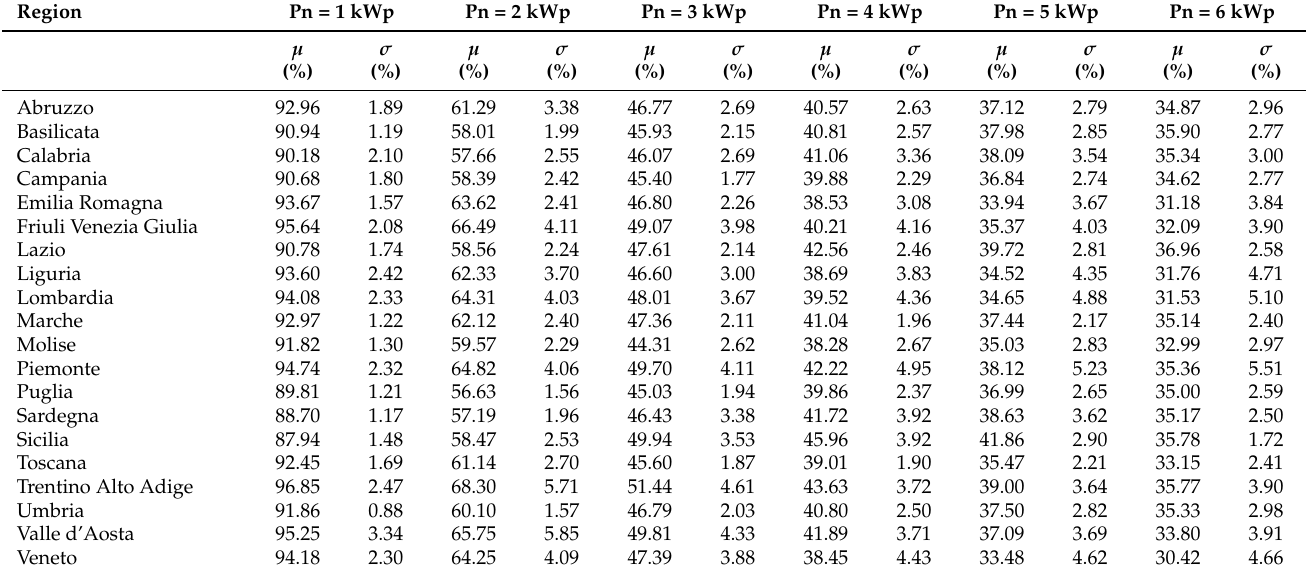
Table 24. Self-Consumption for E L = 4000 kWh with battery.